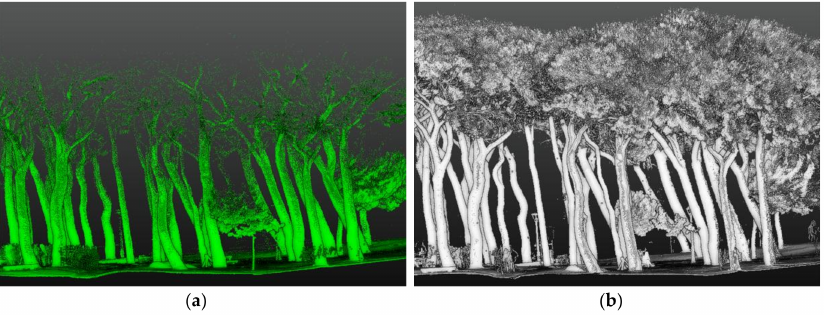
Figure 7. ( a ) Example of a 3D point cloud acquired with the ZEB-REVO and ( b ) with the FARO Focus3D.